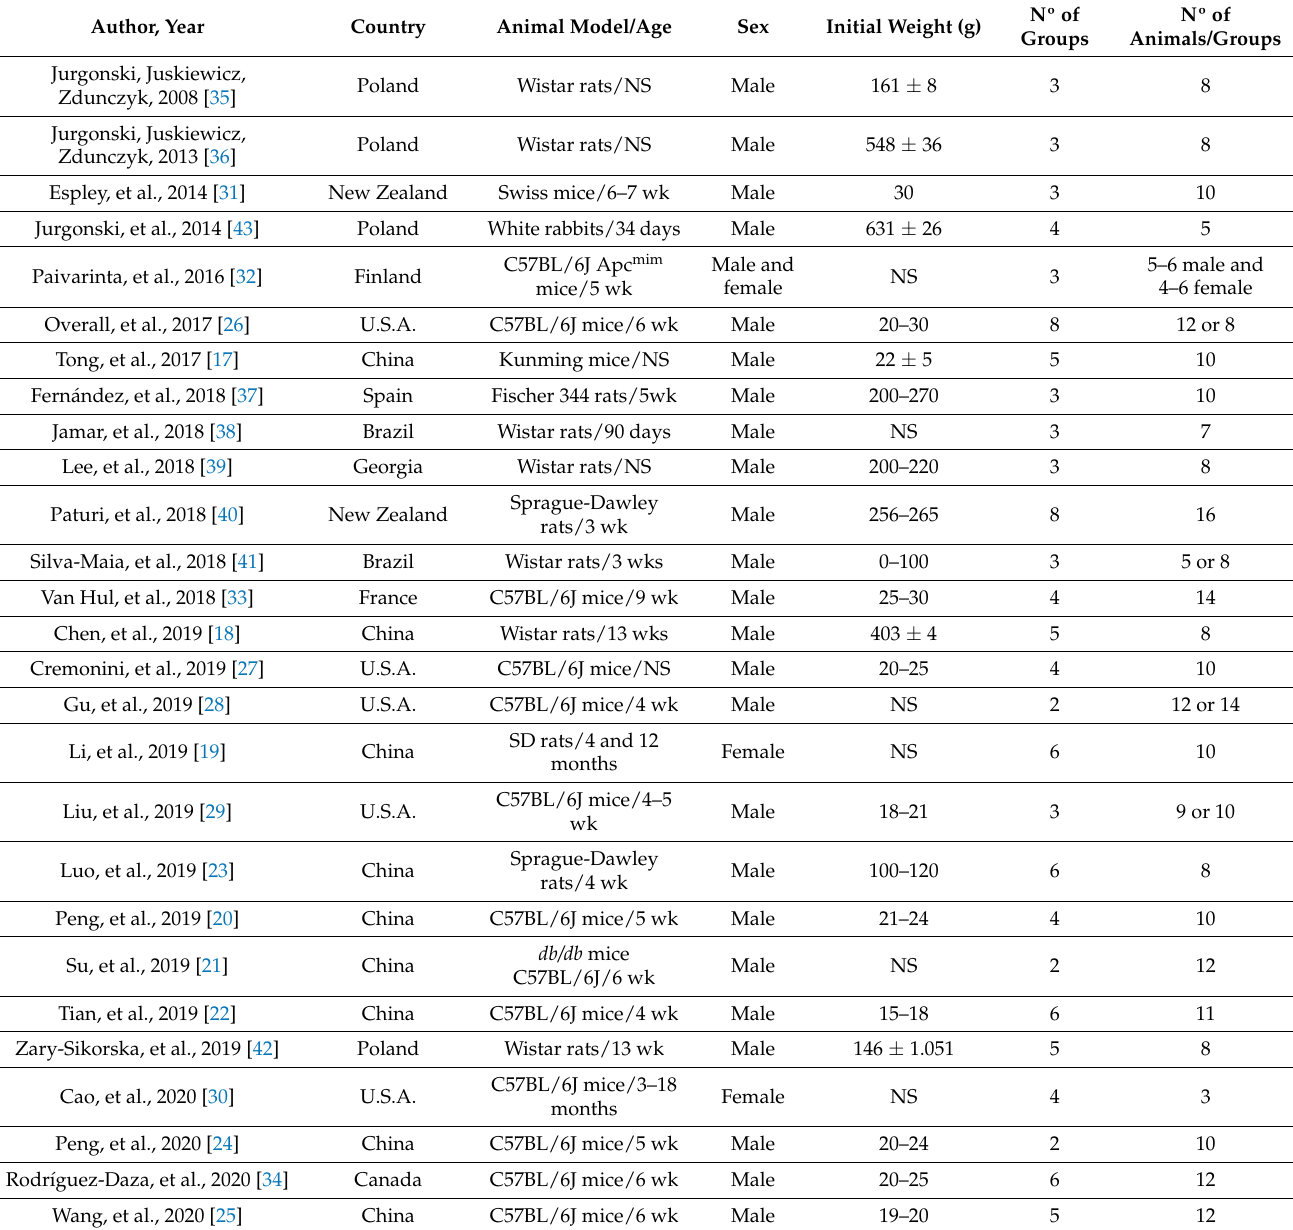
Table 2. Characteristics of animal studies on the effects of anthocyanin on intestinal